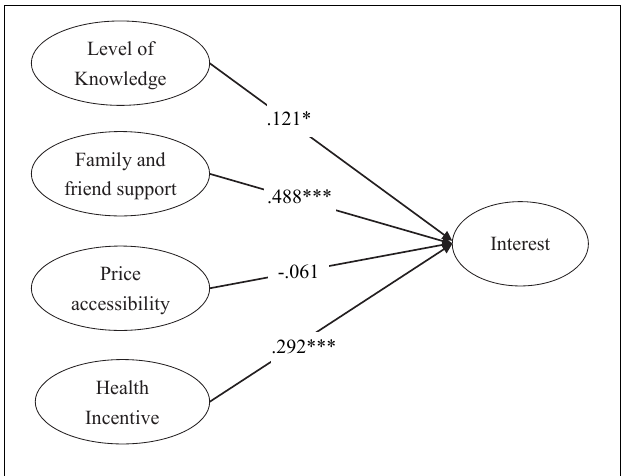
FIGURE 3 | Result of